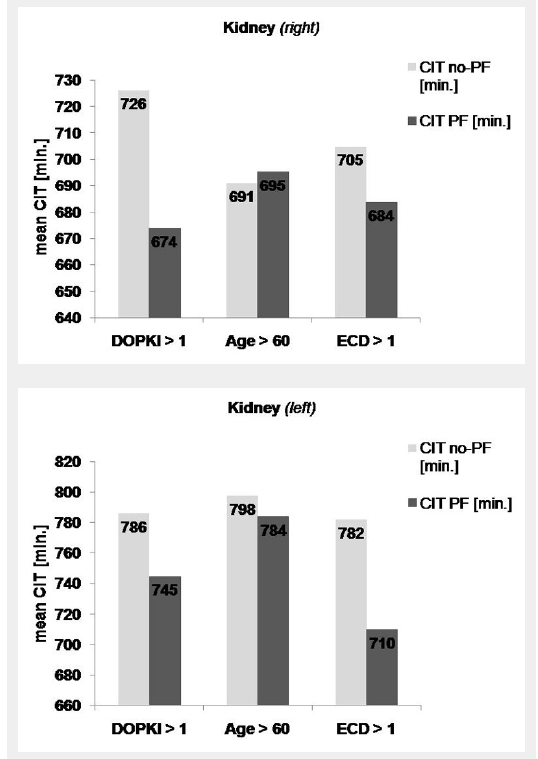
Comparison of CIT in primary function and non-primary function of organs from ECD-DOPKI >1, Age ≥60 (ECD-Age) and ECD>1 (ECD-Age plus ECD-DOPKI) Heart, (b) Lung, (c) Liver, (d) Kidney right and